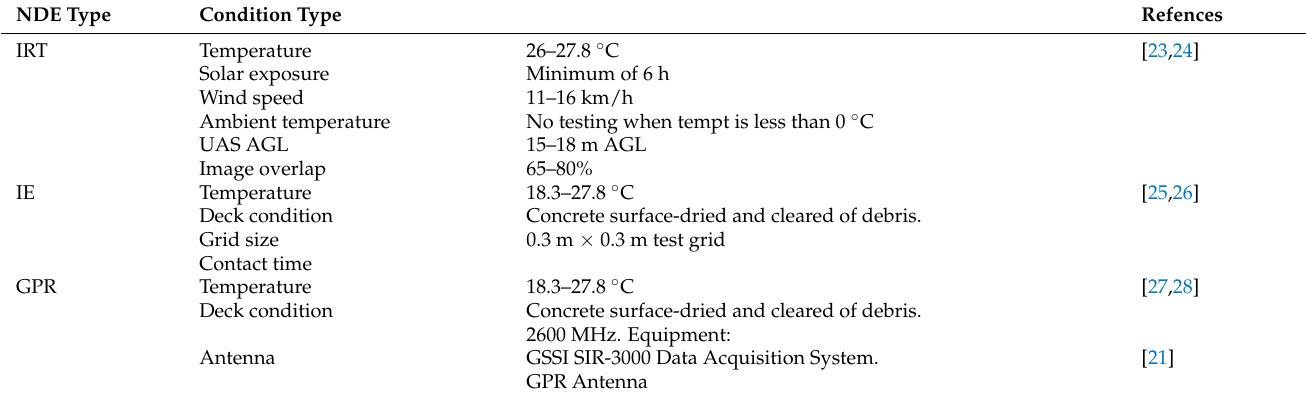
Table 7. Comparison of parameters for NDE data collected in this study with past studies.